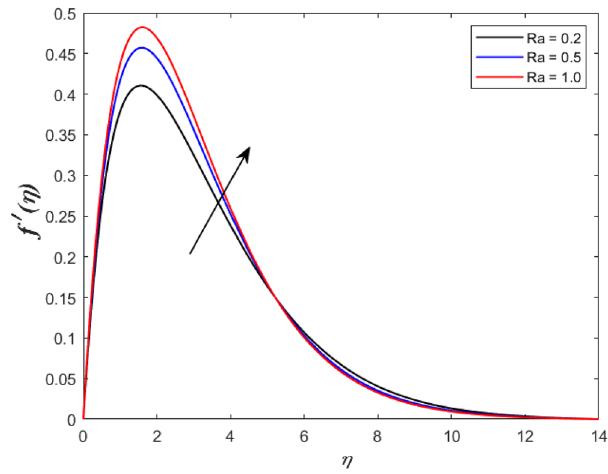
Figure 8. Inspiration of Ra on velocity outline.